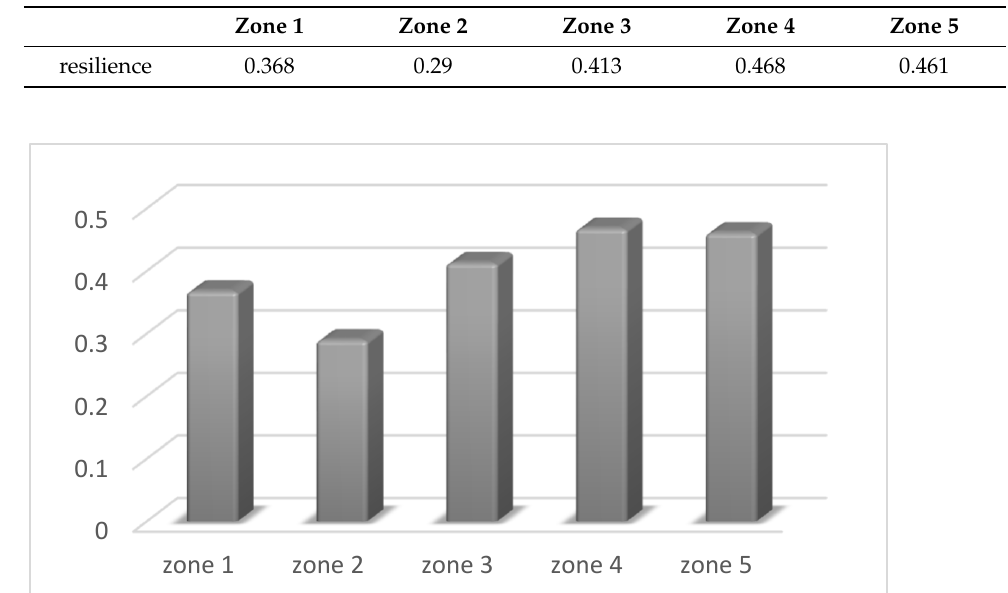
Table 7. The ultimate weighting of the resiliency in zones.